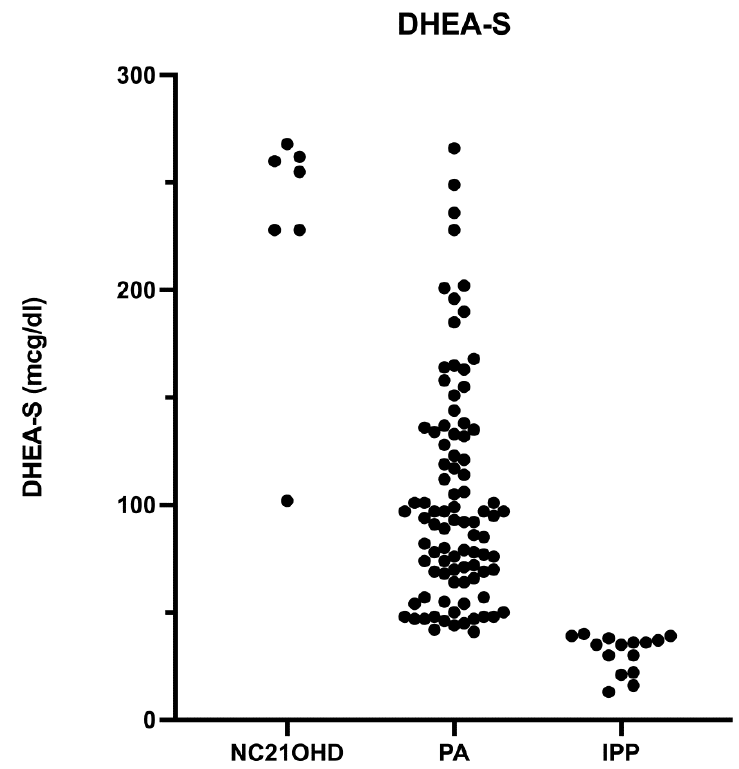
Figure 3. Basal DHEA-S levels in patients subdivided by diagnosis.